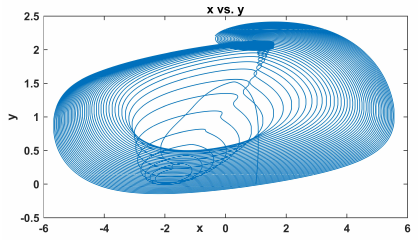
Figure 32. Recovery variable (right) with pa- rameter values a = 2, b = 1.5, c =